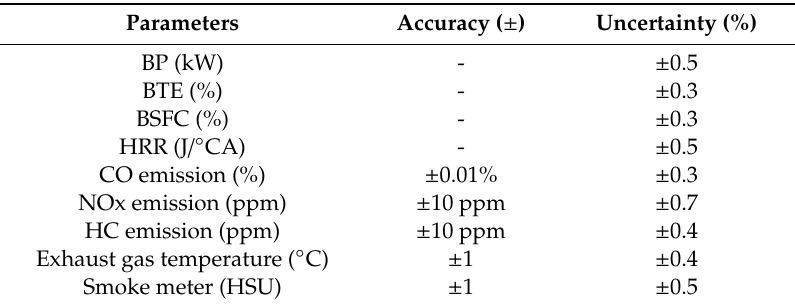
Table 3. Uncertainty analysis of the obtained results.